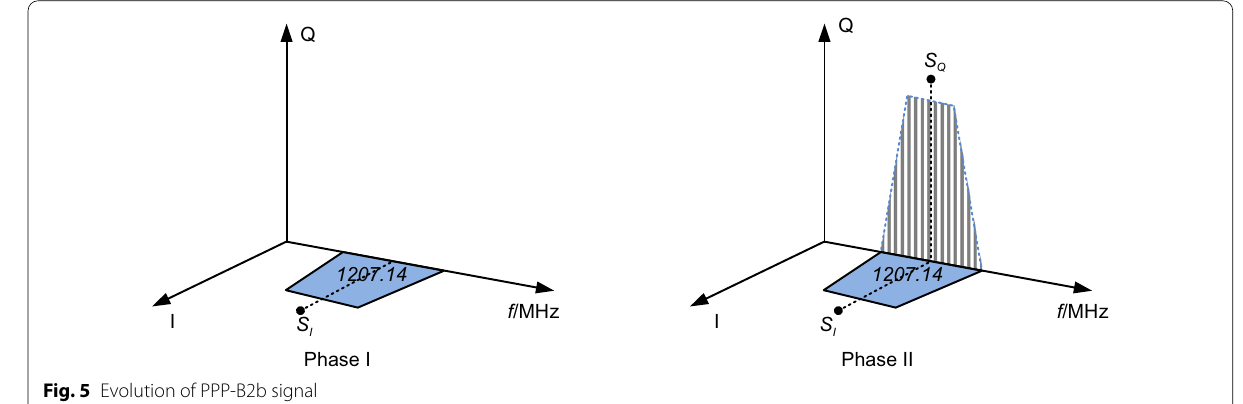
Fig. 5 Evolution of PPP-B2b signal